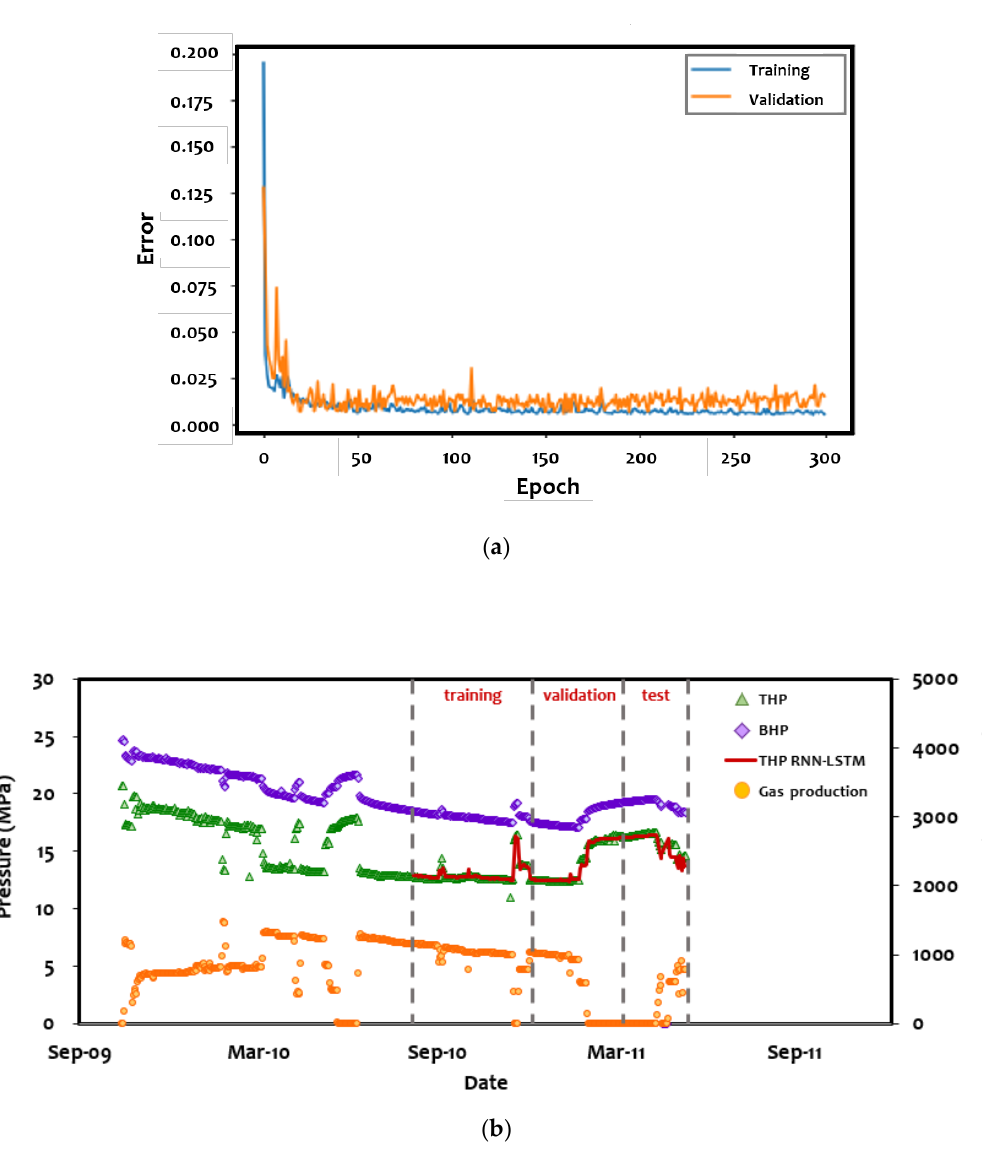
Figure 7. Training results of the RNN-LSTM for Process 1: ( a ) Loss function versus epoch, and ( b ) comparison of the tubing head pressure (THP) model results and field data (modified from Ki et al. [25]).